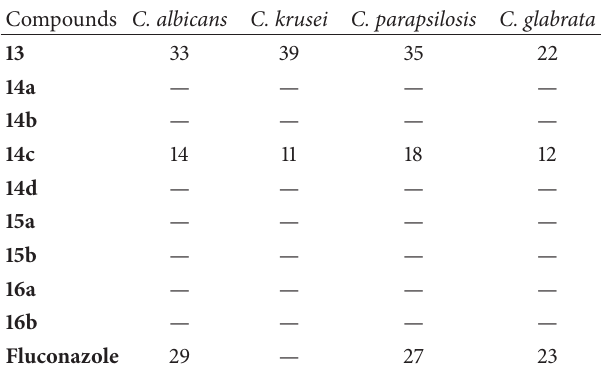
Table 1: Antifungal activity of compounds 13–16 in mean inhibition diameters (mm).